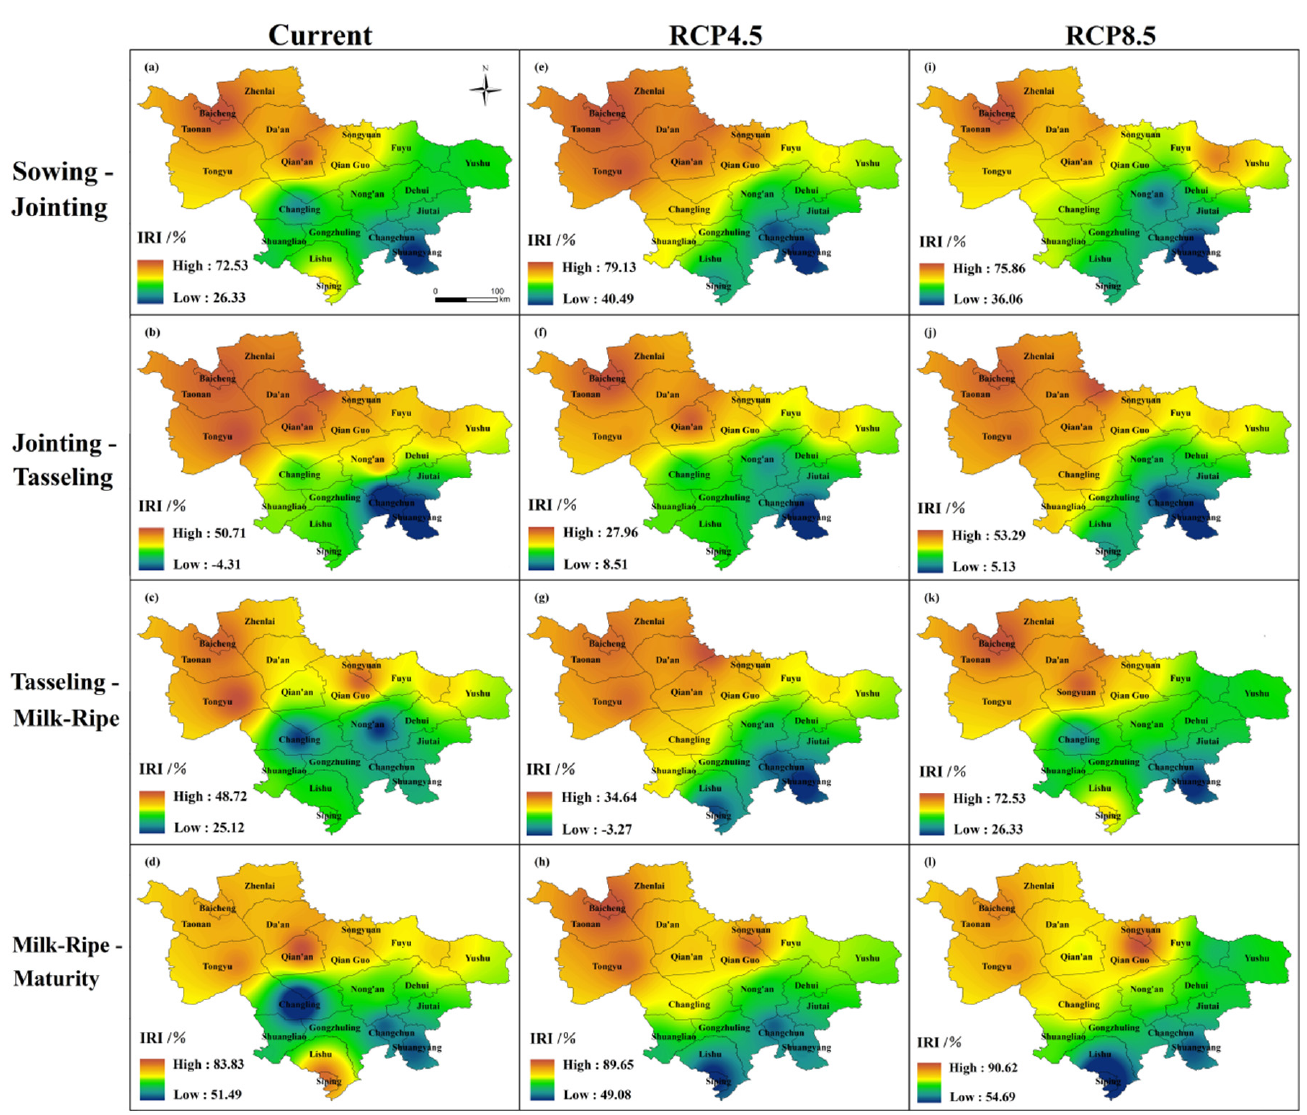
Figure 9. Spatial distribution of the irrigation requirement index (IRI).